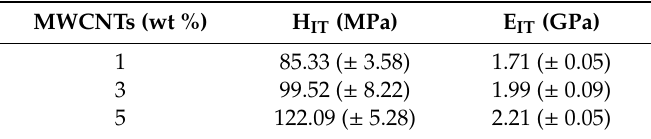
Table 1. Indentation properties of the PP / MWCNT